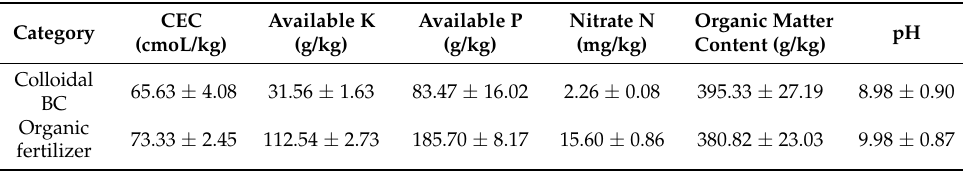
Table 1. Basic properties of colloidal BC and organic